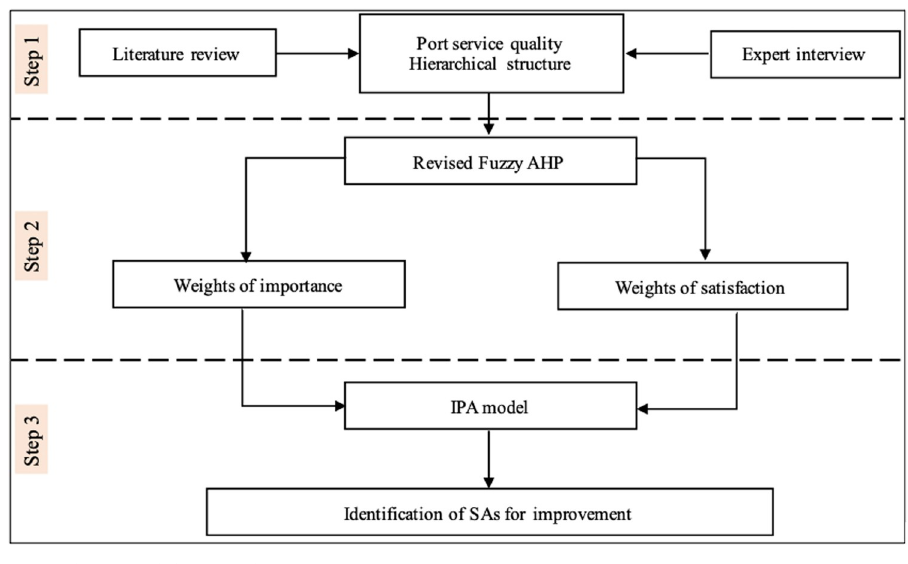
Fig 2. The research